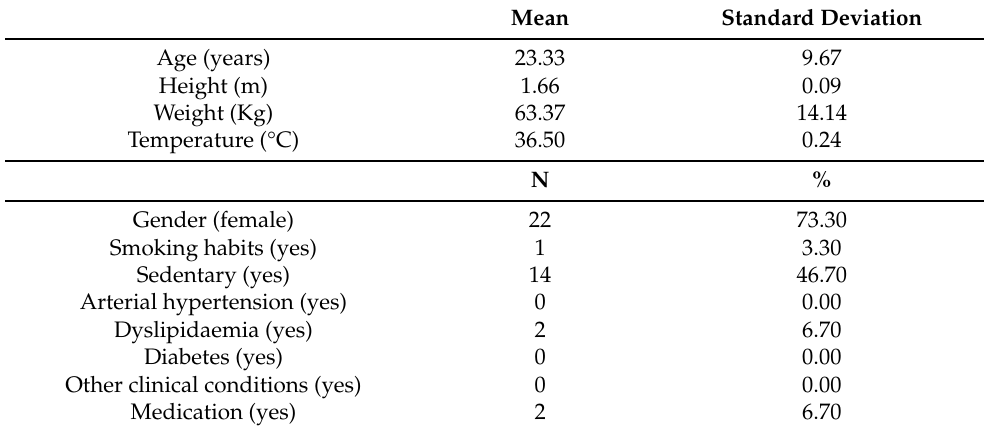
Table 1. Main characteristics of the